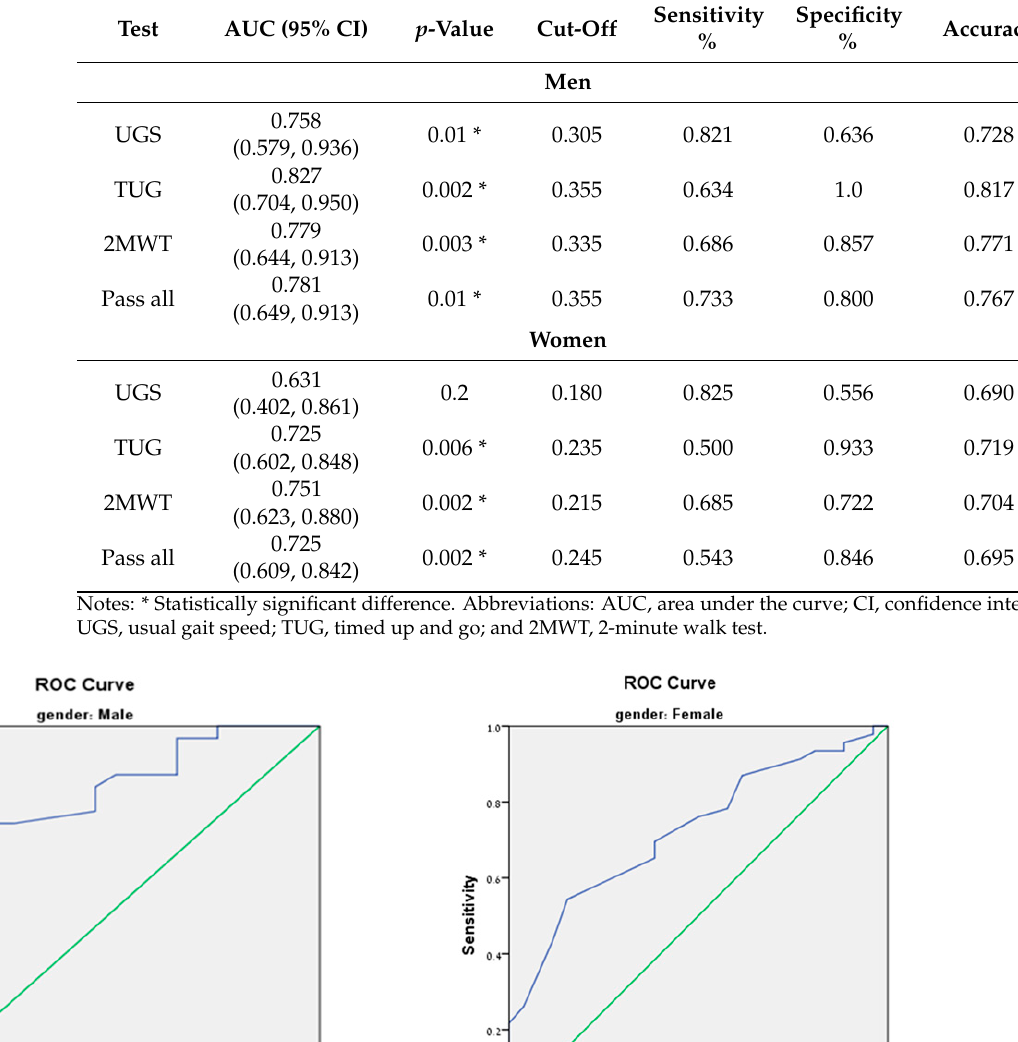
Table 3. Area under the receiving operator curve (AUC) and associated data that best predicted passing each and all three mobility tests (being “mobility-intact”) using HGS/WC in a cohort of older T2DM patients.